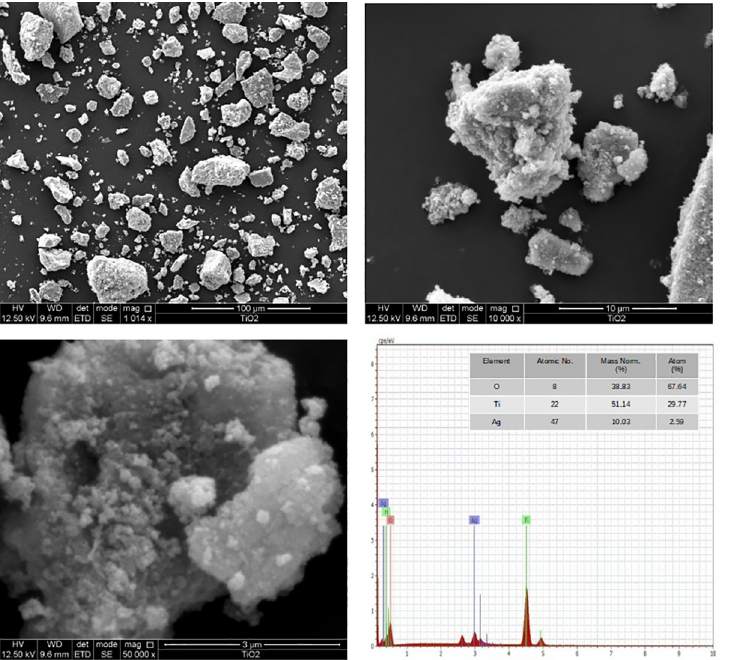
Fig 5. SEM images of the Ag-TiO 2 sample sintered at